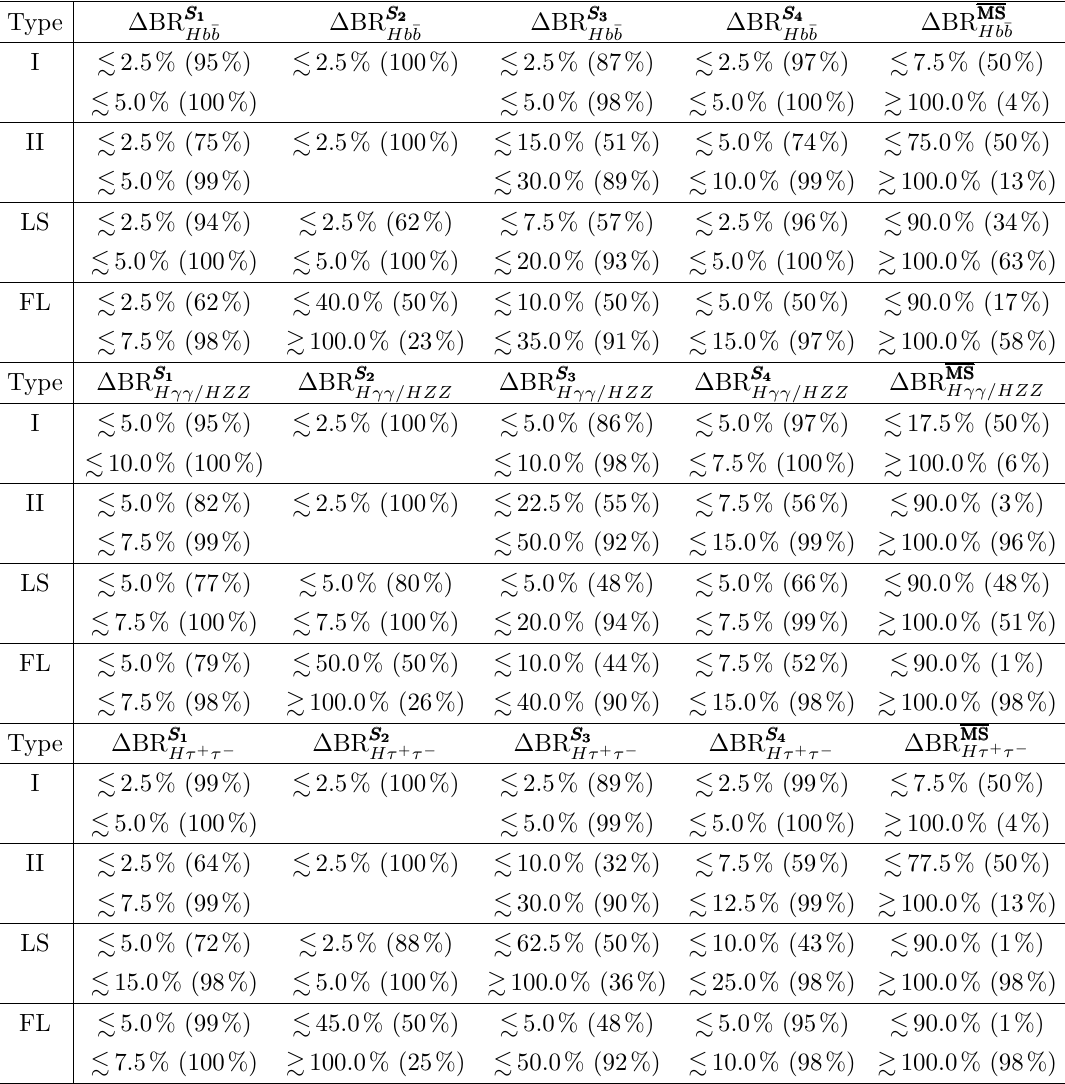
Table 6 . Relative size of the EW corrections to the BRs of the 2HDM SM-like H in the four 2HDM types I, II, LS and FL. For details, we refer to the